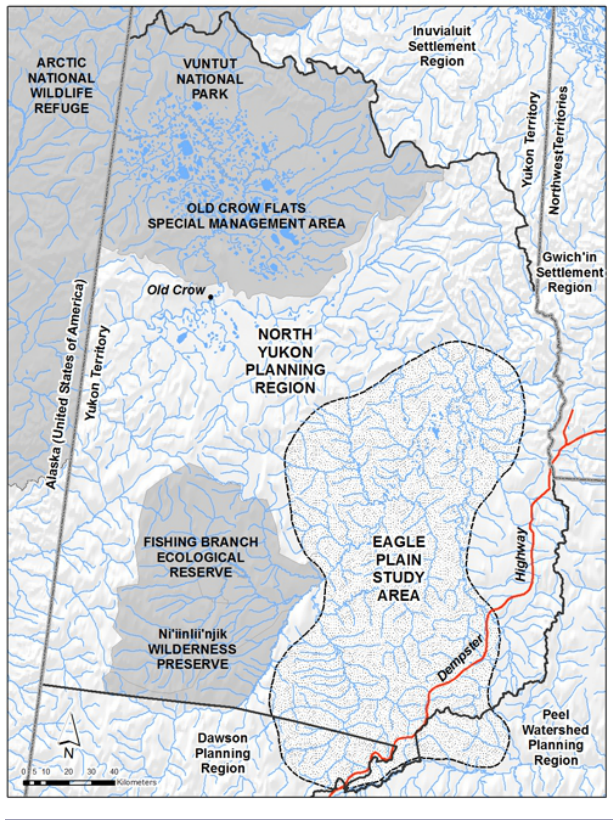
Fig. 3 . Eagle Plain study area within the North Yukon Planning Region.